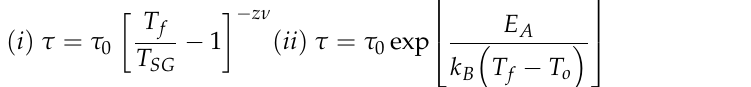
Figure 4. Left ) The fit of the shift of T f to the critical scaling and Right) to the Vogel-Fulcher law.